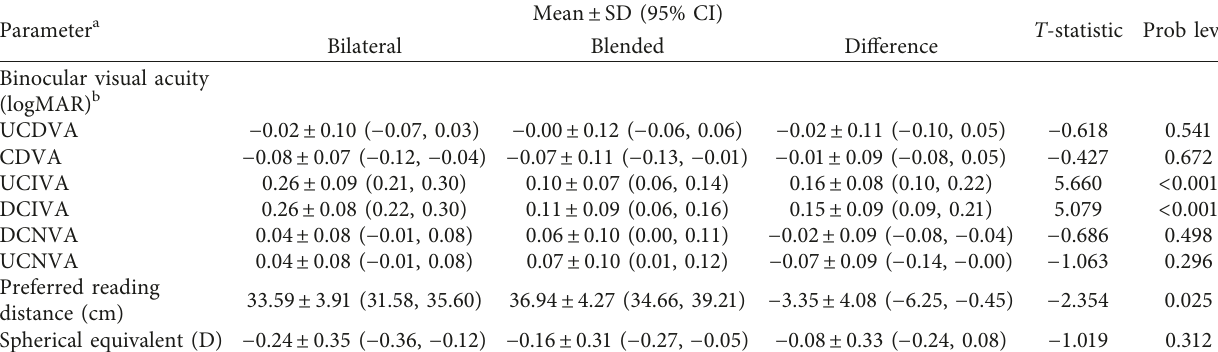
Table 2: Postoperative data of the two groups.